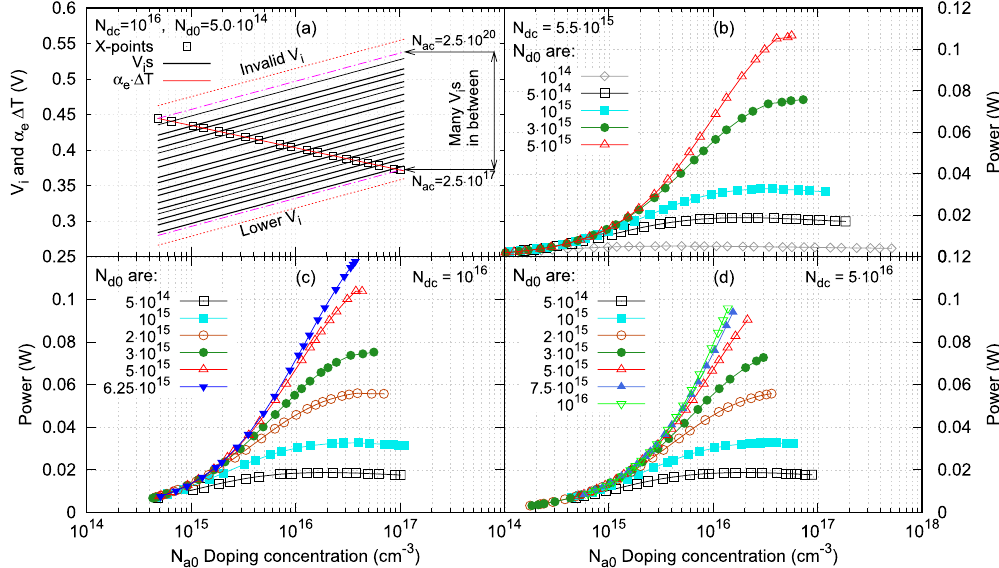
Figure 4. ( a ) Variations of Seebeck voltage and the electrostatic voltage with p -type leg doping density, N a 0 . ( b ) Output power versus N a 0 for the emitter doping density, N dc 16 10 . ( d ) Output power versus N a 0 for N ac